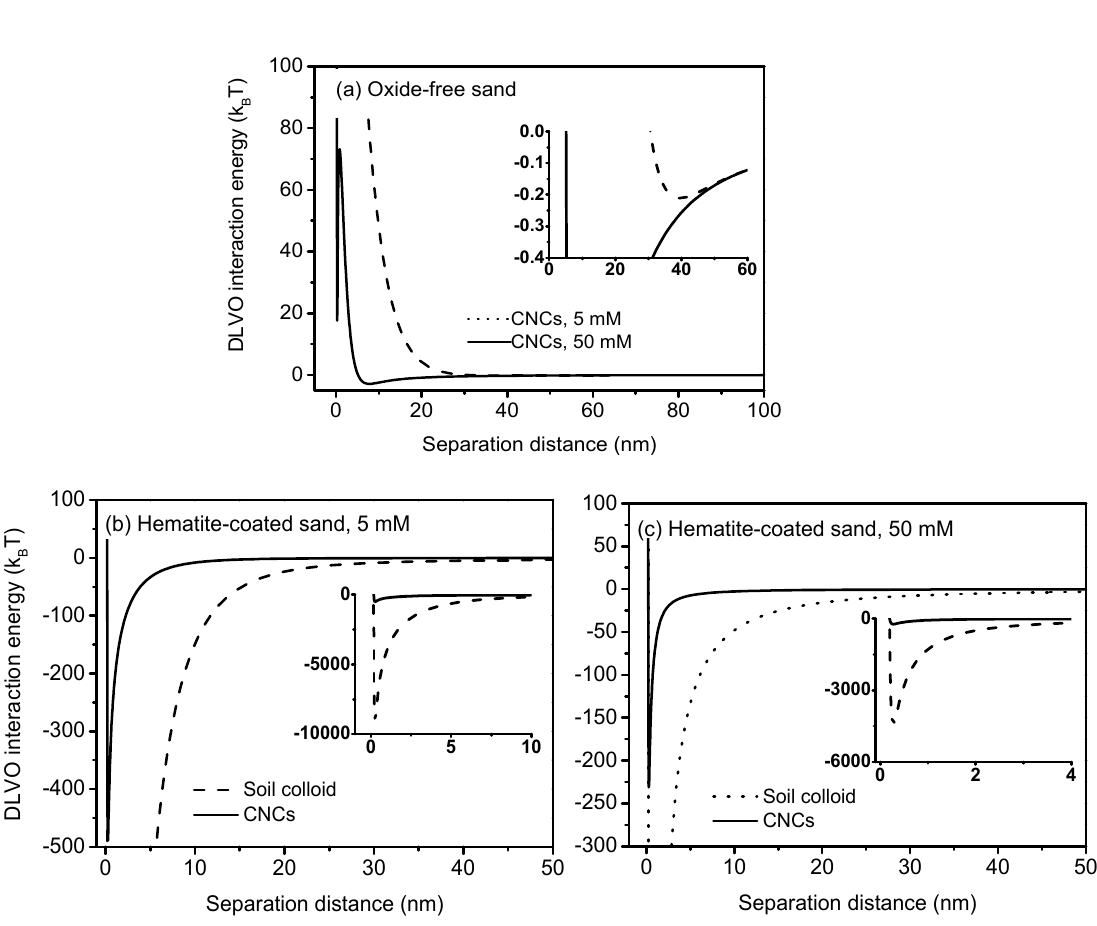
Figure 4. Predicted DLVO interaction energy profiles between CNCs and oxide-free sand ( a ) and between CNCs/soil colloids and hematite-coated sand at 5 mM ( b ) and 50 mM ( c ). Subgraphs are detailed view of primary minima or secondary minima.